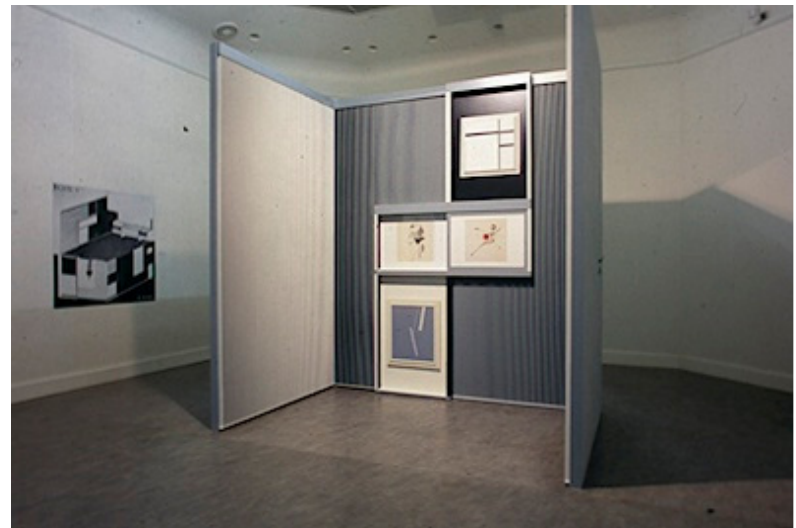
Figure 11. El Lissitzky, One wall of the ‘Abstract Cabinet’, 1927 (reconstruction 1990). Collection Van Abbemuseum. Photo from Van Abbemuseum exhibition archive. Photographer unknown.